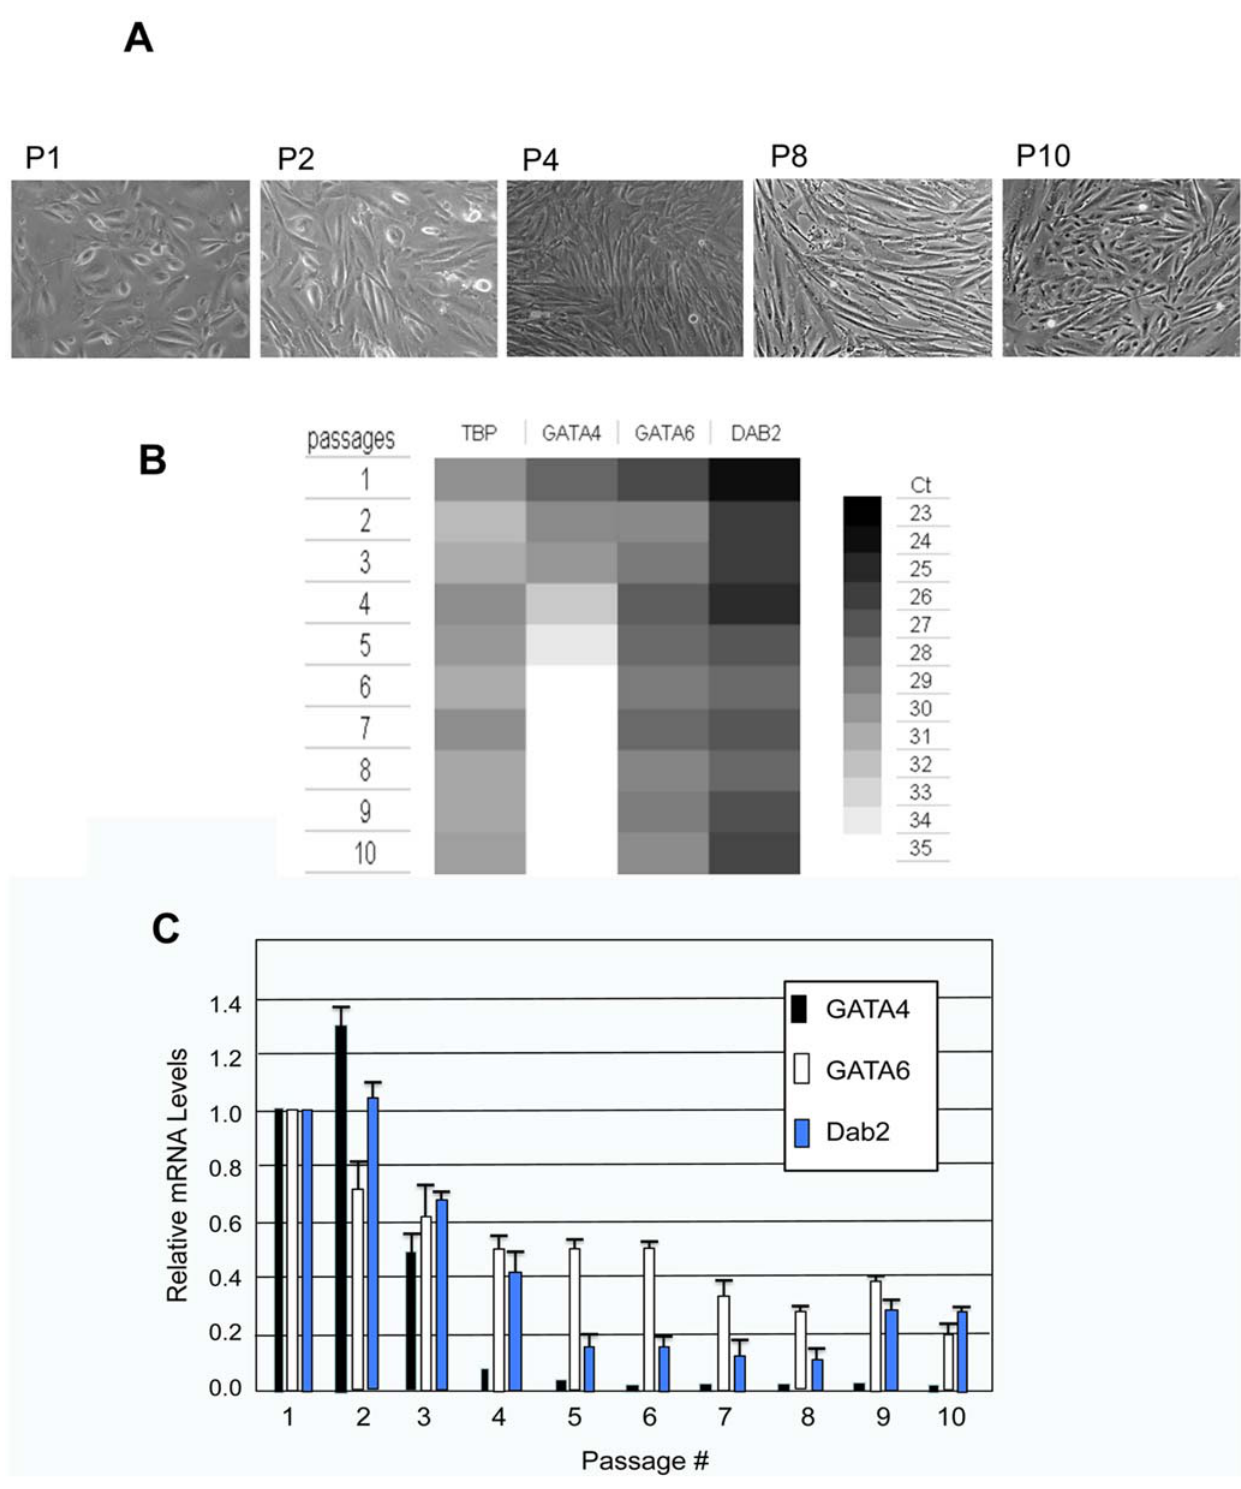
Figure 4. Reduction of GATA4 and GATA6 expression upon culturing of ovarian surface epithelial cells. Human ovarian surface epithelial cells were isolated from morphologically normal human ovaries obtained from oophorectomy surgery. The cells were passaged 10 times over a period of 3 months, and cells were harvested from each passage for mRNA analysis. A . Morphology of the cells in passage # 1, 2, 4, 6, 8, 10. B . The total RNA were used for quantitative real-time RT-PCR to assay mRNA levels. The results are presented as a ‘‘heat-map’’. C . The amount of mRNA relative to passage 1 was quantitated and presented as a bar graph.